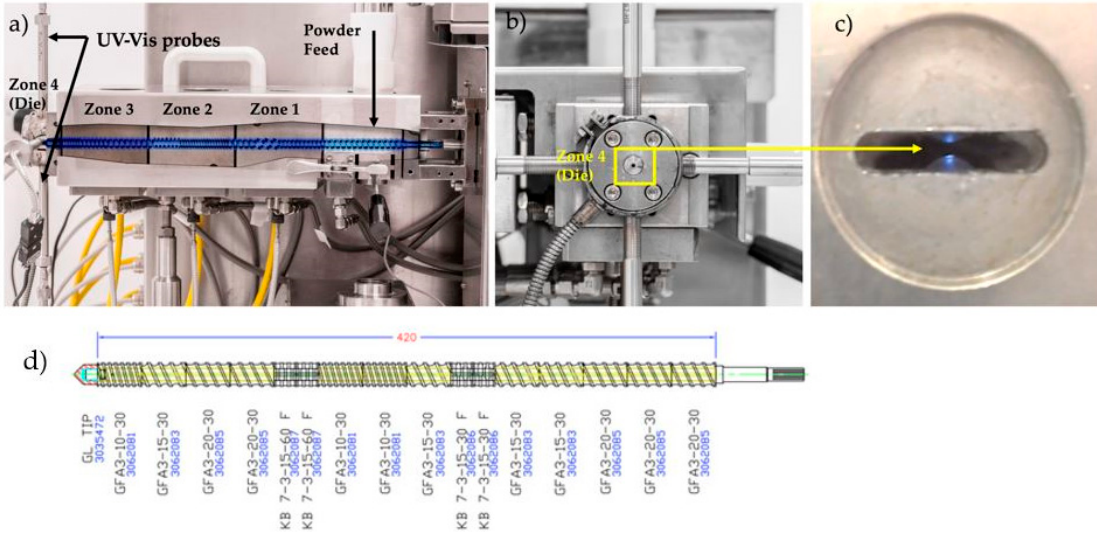
Figure 2. ( a ) Side view of the extruder; ( b ) Front view (zone 4 is where the UV-Vis probes are located), ( c ) View of the probes gap (0.5–0.8 mm) inside the zone 4; ( d ) standard screw configuration set (Leistritz Nano16 with co-rotating twin screws).